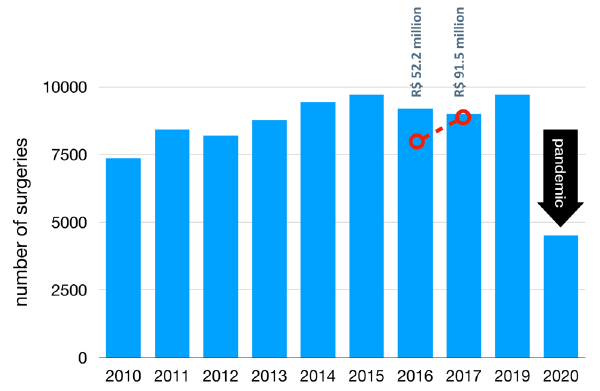
Fig. 1 - Incremental number of pediatric cardiac surgeries over one year by government funding enhancement, with the 2020 reduction due to the pandemic. Blue bars represent the number of procedures each year and the red dotted line represents the government budget. R$=Brazilian